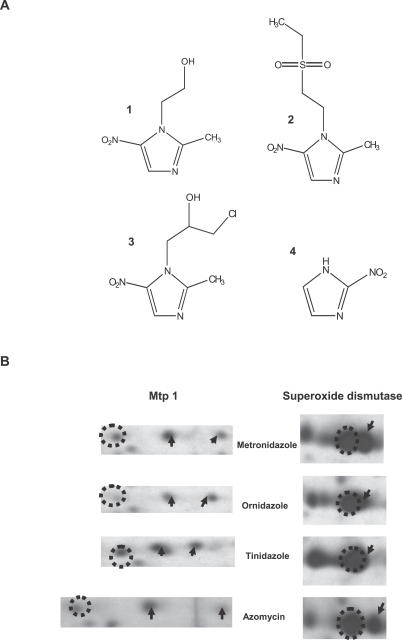
Different Nitroimidazoles Shift the Same Target Proteins to a Different Extent(A) The nitroimidazoles used in this study are shown: the 5-nitroimidazoles metronidazole (1), tinidazole (2), and ornidazole (3), and the 2-nitroimidazole azomycin (4). Different side chains result in different contributions of the compounds to the pI shifts on 2D gels.(B) Adduct formation of the same proteins with different nitroimidazoles. The same proteins were shifted with the 5-nitroimidazoles metronidazole, ornidazole, and tinidiazole, and with the 2-nitroimidazole azomycin. The width of the shifts in pI depended on the total charge of the nitroimidazole used, which is determined by its side chains. Shifts are exemplified by two of the proteins found: superoxide dismutase and metronidazole target protein 1. The unmodified proteins are encircled, and shifted proteins are indicated by arrows.